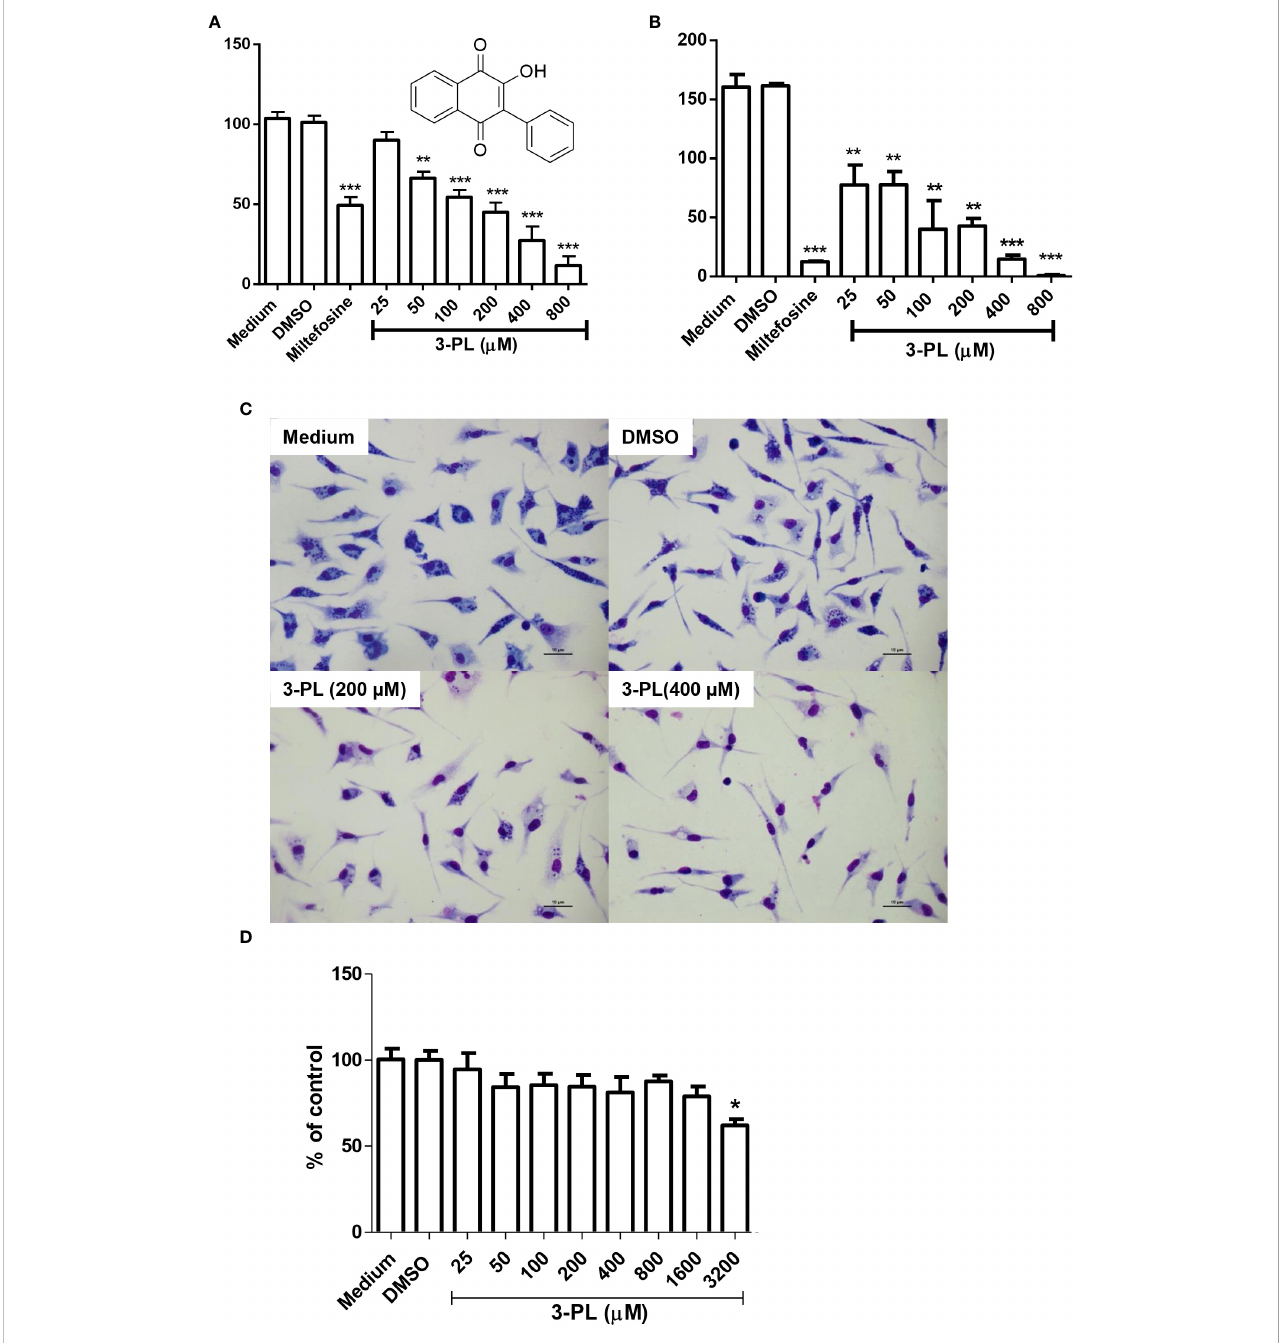
FIGURE 1 In vitro activity of 3-PL against L. (Viannia) braziliensis amastigotes and macrophage toxicity. (A-C) Murine macrophage monolayers were infected with stationary-phase promastigote of L. ( V. ) braziliensis in a ratio of 5:1 (parasites/macrophage). Infected macrophages were incubated in an atmosphere of 5% CO2 at 37°C, with RPMI 1640 medium supplemented with 10% FBS for 24h to differentiate amastigotes. Afterwards, the infected monolayers were submitted to treatment with indicated concentrations of 3-PL or 3 µM miltefosine for 48h. (A) The infection index was determined by counting at least 200 macrophages and expressed as % of control or (B) the treated infected macrophages were washed twice and incubated with Schneider ’ s medium plus 20% FBS at 28°C for more than 48h and promastigotes were counted. (C) Representative light microscopy images of infected macrophage monolayers after 48h of treatment. (D) Toxicity on peritoneal murine macrophages treated during 48h at 5% CO 2 /37°C. Results (A,B and D) were presented as means ± SD; n=3. *p < 0.05, **p < 0.01 and ***p < 0.001 in relation to control